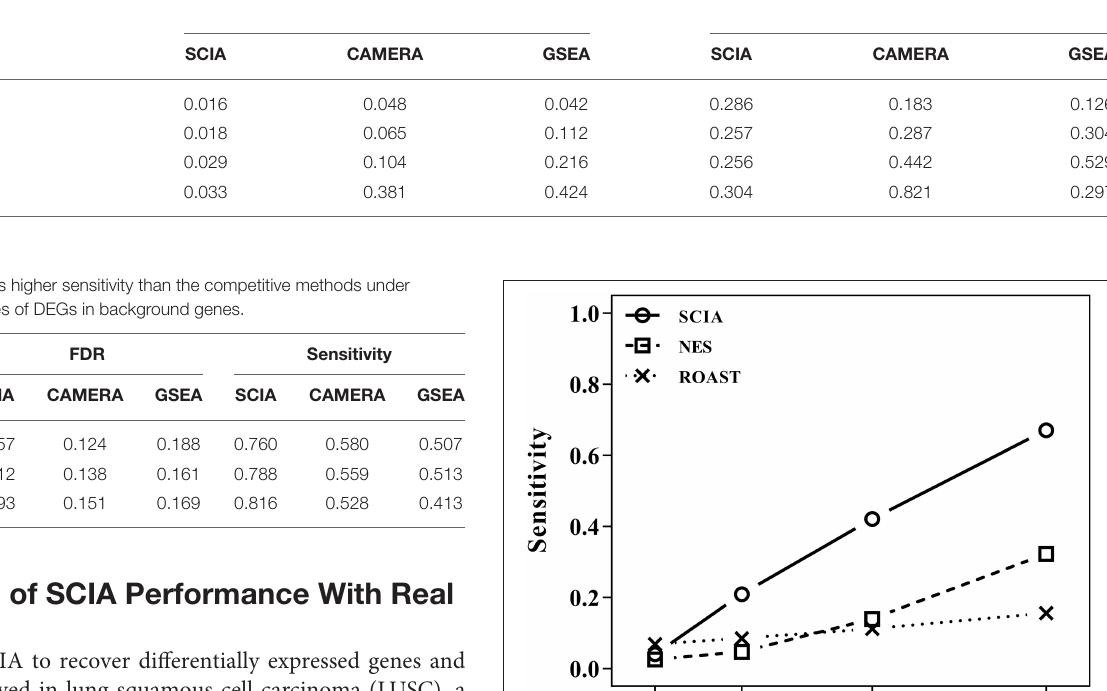
TABLE 3 | SCIA has lower FDRs than the competitive methods under different inter-gene correlations in simulated datasets. Pearson correlation coefficients